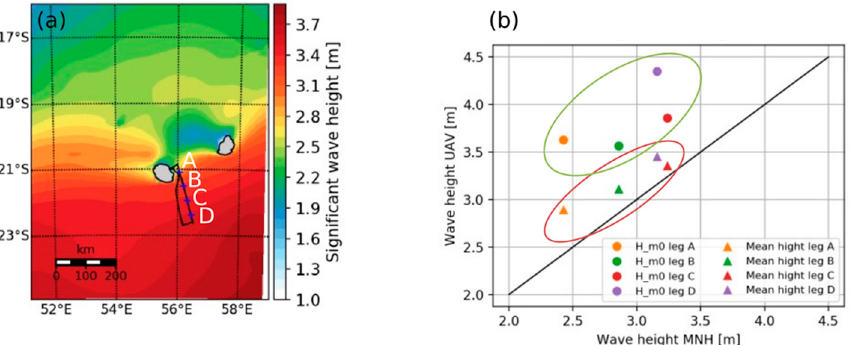
Figure 19. ( a ) WW3 simulation of significant wave height on 29 March 2019 with the BOREAL UAS flight overlaid on the image (black line). The blue crosses correspond to A, B, C and D legs of the flight at 100 m asl. ( b ) Significant wave height (H_m0) and mean wave height from the BOREAL UAS observations compared to wave height simulated by WW3.